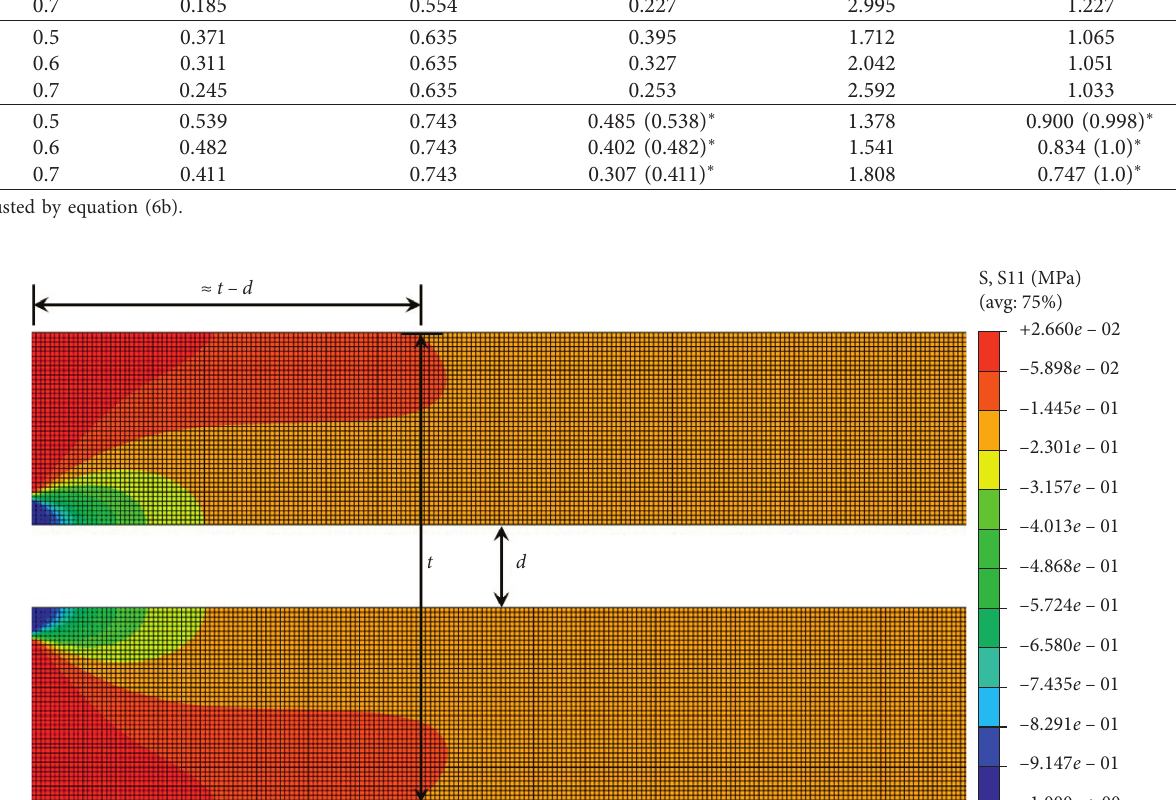
� 0 . 6). / t � 0 . 3, and d / b eff eff